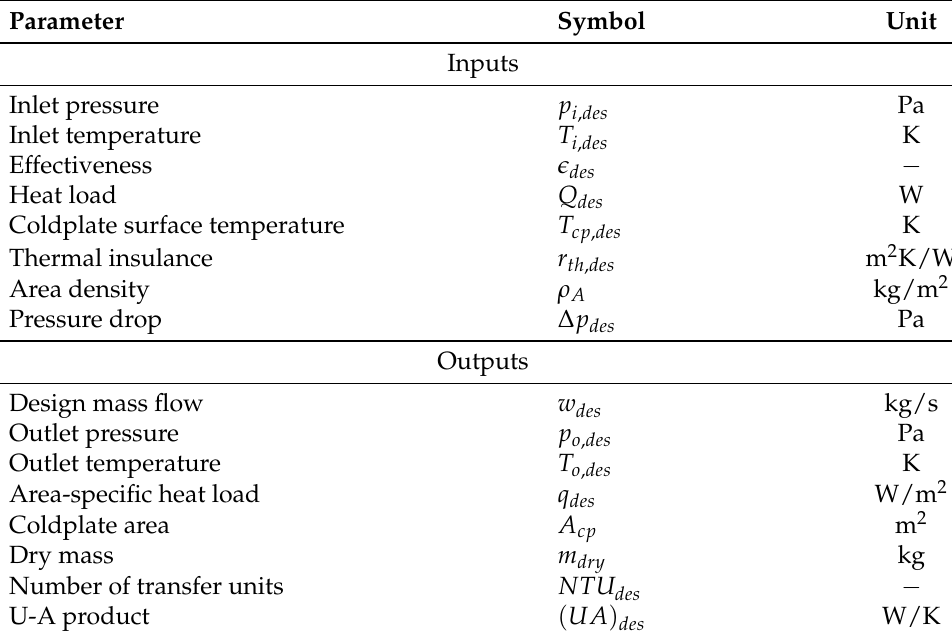
Table A1. Design parameters for the coldplate